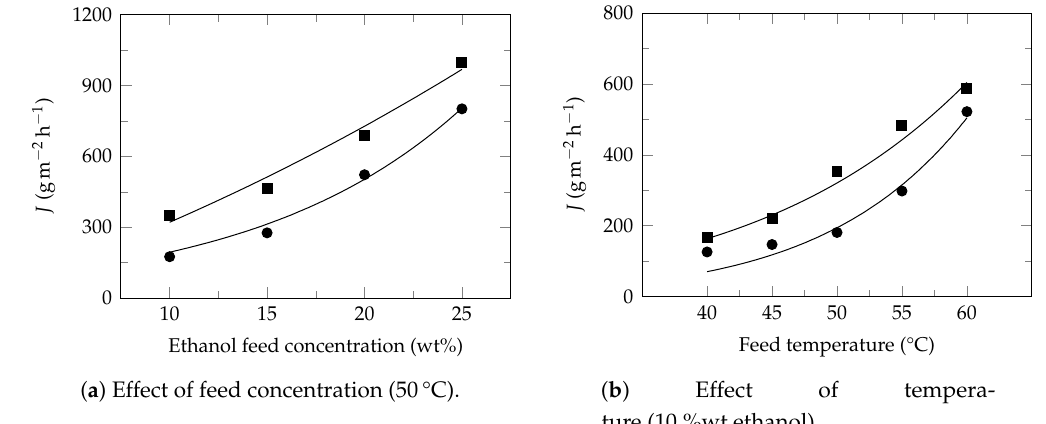
Figure 9. Ethanol recovery. Experimental data extracted from Zhan et al. 2020 [59]. Experimental flux: ethanol ( (cid:4) ) and water ( ). Model flux (—). Pervaporation conditions: membrane: POSS-g-PDMS, effective area: 22cm 2 , thickness: (cid:32) 30µm,permeate pressure: 500Pa, Table